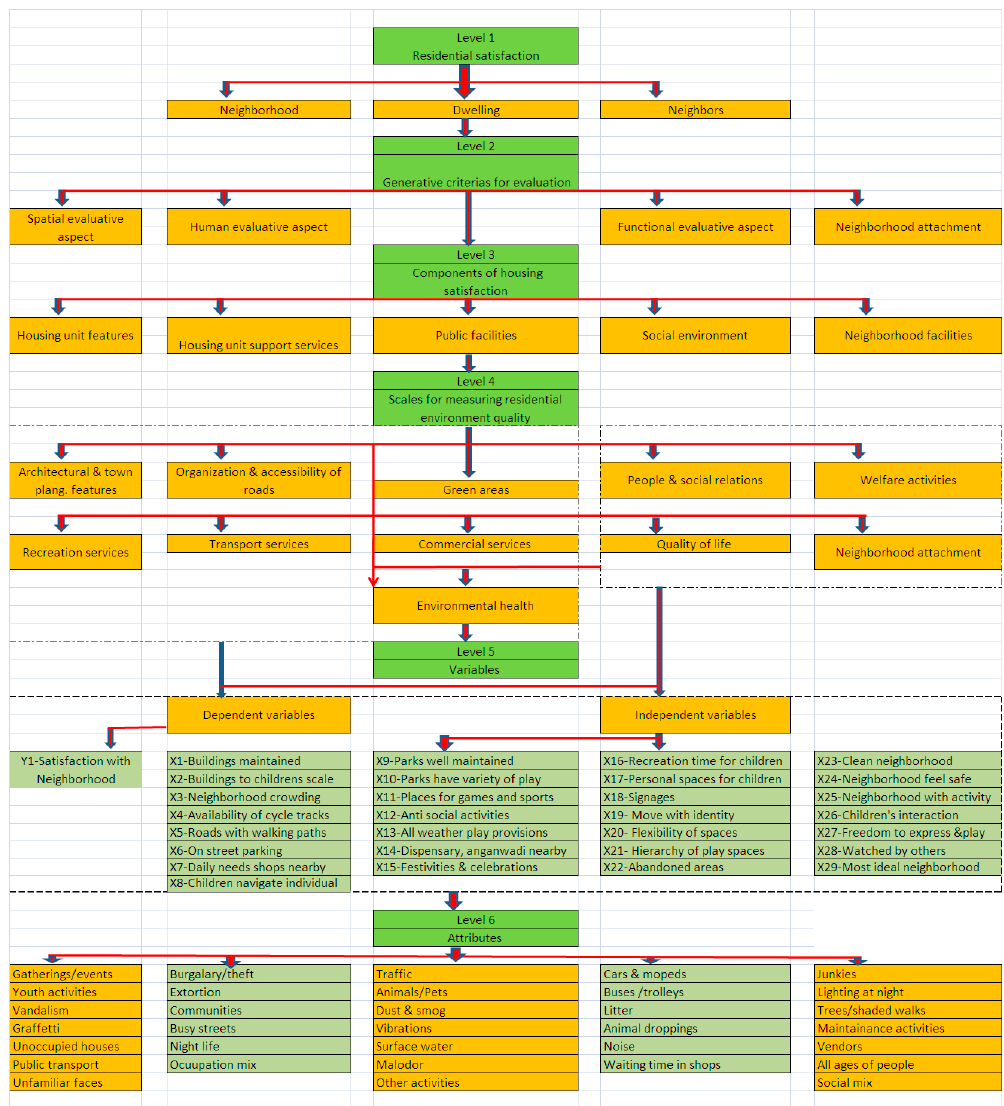
Figure 9. Theoretical model of RESS.